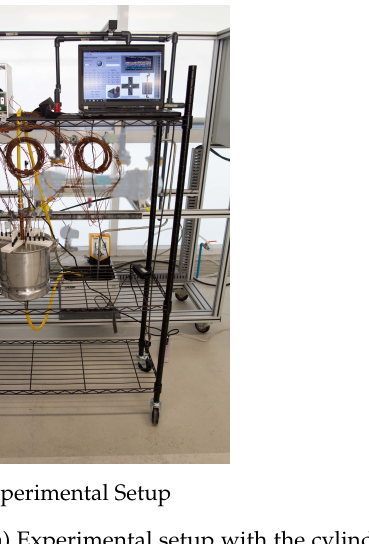
Figure 3. ( a ) Experimental setup with the cylindrical unit and thermocouple array. ( b ) Schematic representation of the experimental setup with the following components: 1. Lauda Thermostatic Bath, 2. Thermal energy-storage unit, 3. SCXI-1000 National Instruments module for thermocouple signal conditioning, 4. Laptop for data processing, A. 1 K-type thermocouple for heat bath temperature sensing, B. 1 K-type thermocouple for HTF inlet temperature sensing, C. 22 K-type thermocouple array for temperature sensing at the copper–PCM interface, aluminium–PCM interface and PCM temperature field estimation and D. 1 K-type thermocouple for HTF outlet temperature sensing. E. 1 K-type thermocouple for ambient temperature sensing.